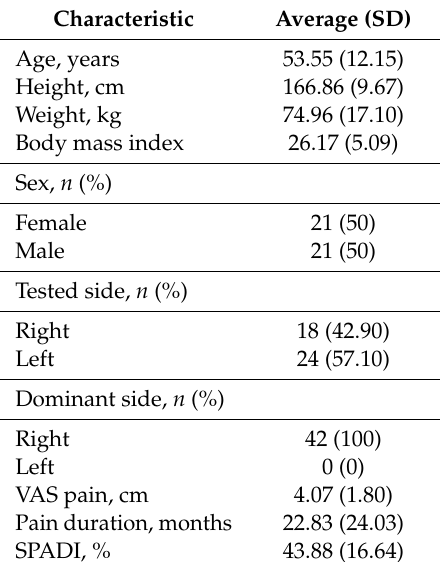
Figure 2. Flow diagram of subjects. Table 1. Patient characteristics ( n = 42).